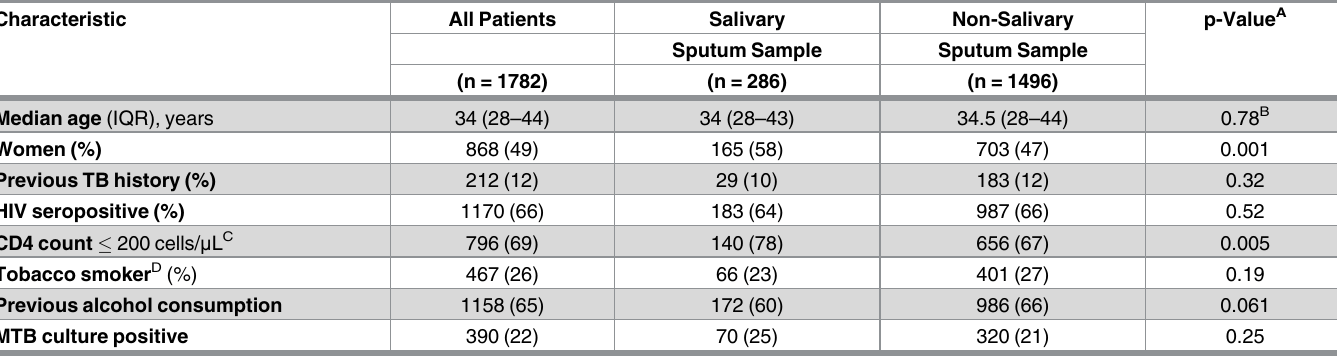
Table 1. Clinical and demographic